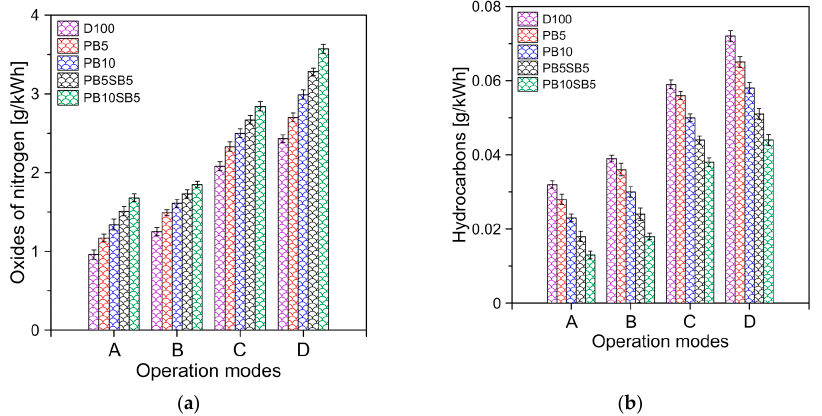
Figure 11. ( a ) NOx and ( b ) HC, emissions for fuels tested.